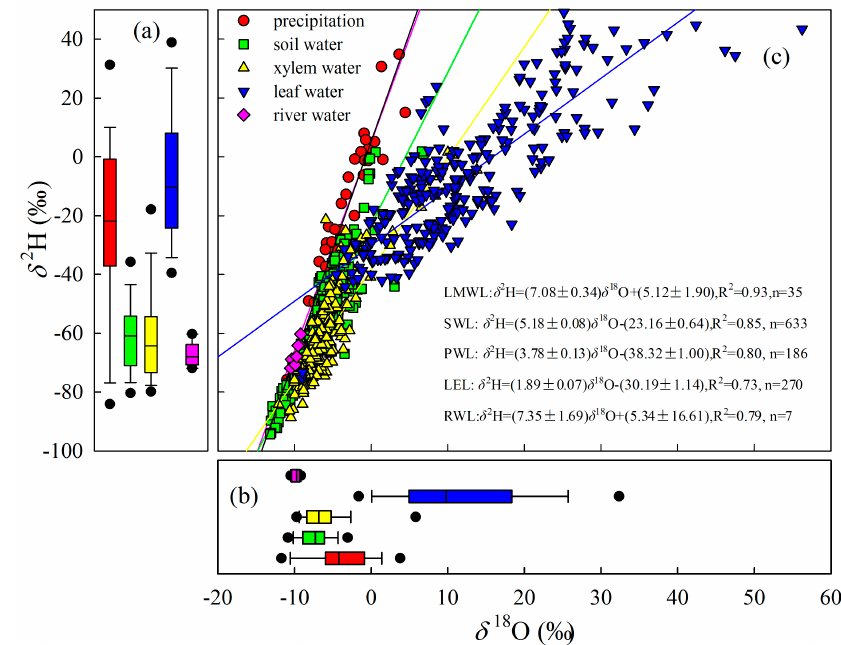
Figure 2. Relationships between δ 2 H and δ 18 O of precipitation, soil water, xylem water, leaf water and river water. ( a , b ) are the hydrogen and oxygen isotopic composition of di ff erent water bodies, respectively, and c is the water line equation of di ff erent water bodies.